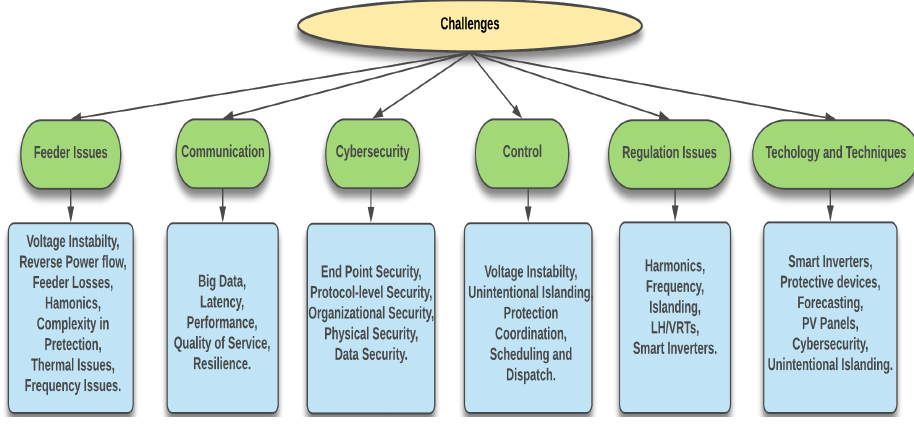
Figure 3. Classification of various challenges with PV